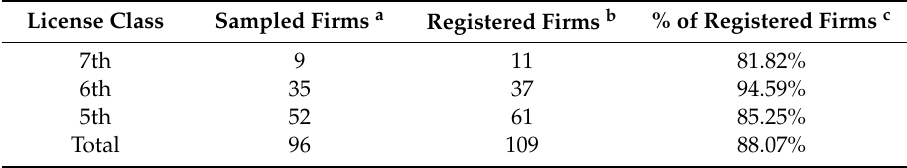
Table 1. Greek construction enterprises sample